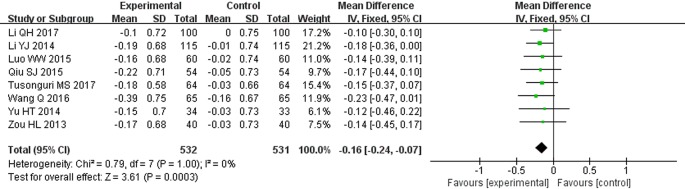
Meta-analysis for comparison of cystatin-C (Cys-C) levels between the experimental and control groups.